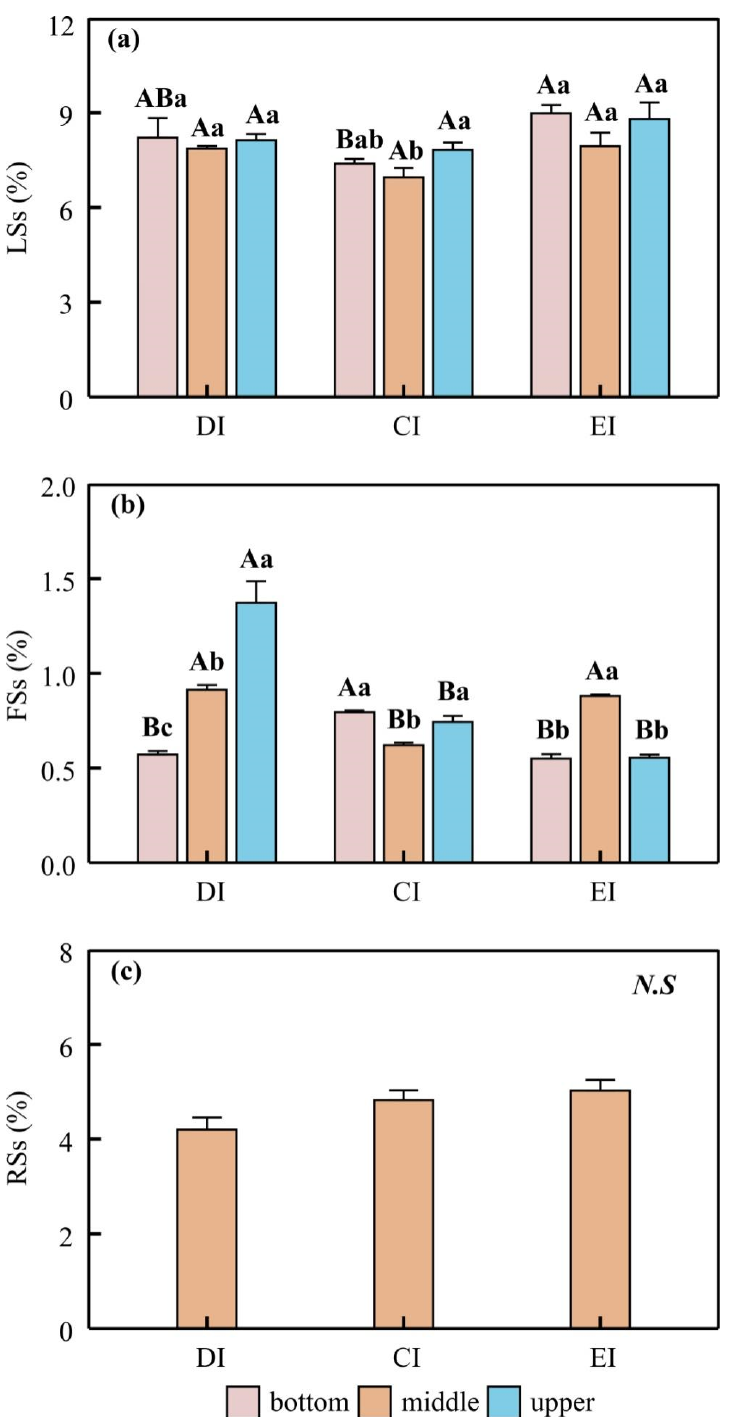
Figure 4. Soluble sugar content of leaves (LSs, ( a )), fruit kernels (FSs, ( b )) and fine roots (RSs, ( c )) at different irrigation levels and tree heights. Different lowercase letters indicate significant differences between different tree heights under the same treatment; Different capital letters indicate significant differences between different treatments at the same tree height; N.S indicates no significant difference between treatments ( p < 0.05, mean ± standard error, n = 3–4).